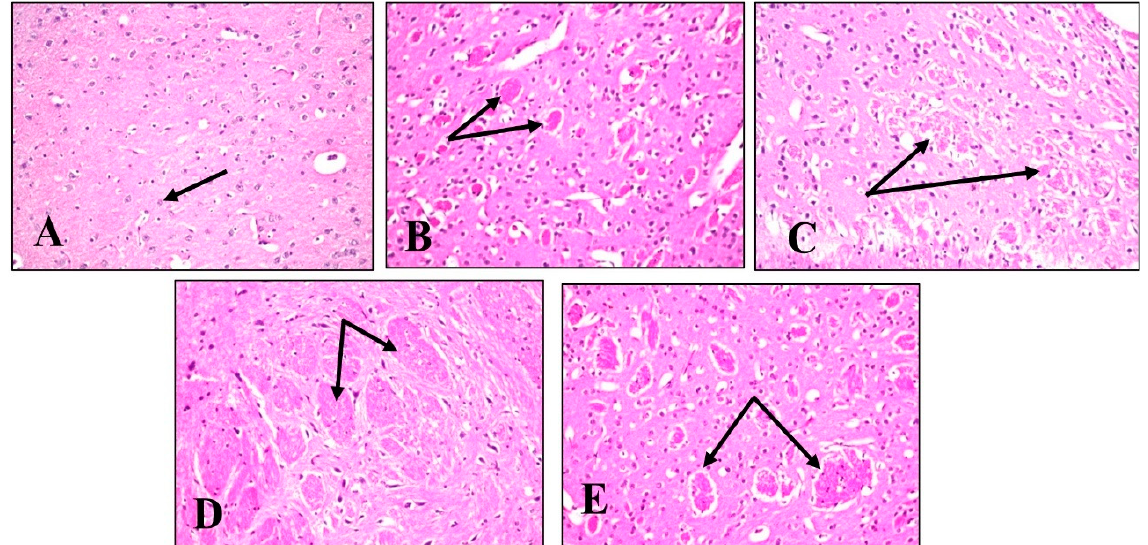
Figure 9. Histopathology of mice brain (Striatum sections) with H&E × 40. ( A ) Normal control group showing normal histological findings (Black arrow-normal neuron). ( B ) LPS-administered mice group showing multiple focal eosinophilic plagues formation (Black arrow). ( C ) BME-administered mice group showing fine eosinophilic plagues formation (Black arrow). ( D ) BDMF-administered mice group showing eosinophilic plagues formation (Black arrow). ( E ) BBF-administered mice group showing focal eosinophilic plagues formation (Black arrow). BME: B. armeniaca methanolic extract; BDMF: B. armeniaca dichloromethane fraction; BBF: B. armeniaca butanol fraction; LPS: lipopolysaccharide.